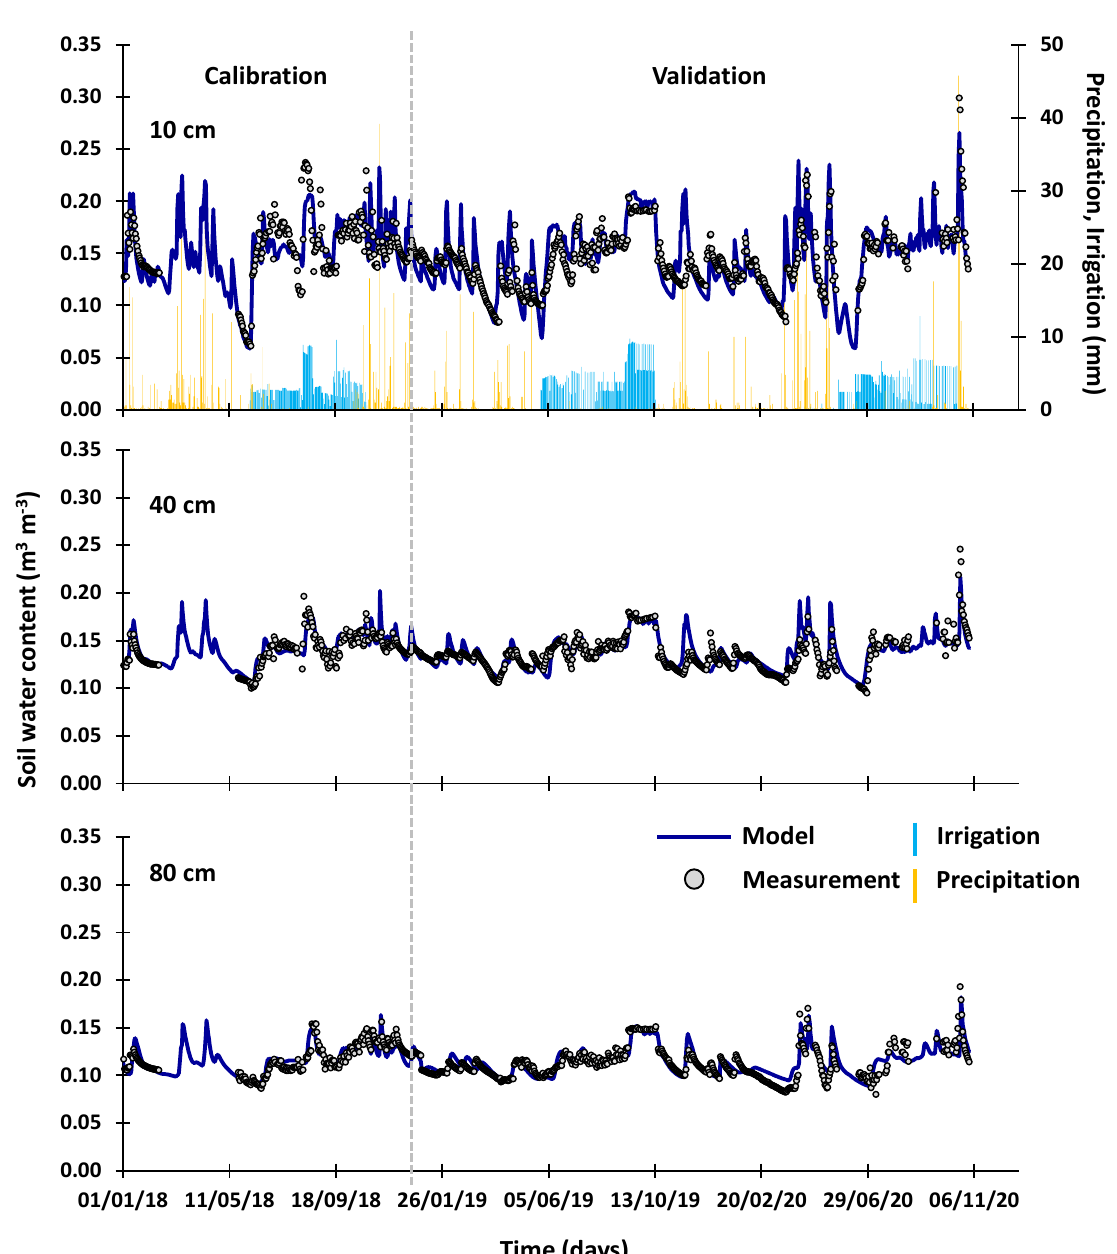
Figure 3. Measured and simulated soil water contents at 10, 40, and 80 cm depths during the 2018, 2019, and 2020 seasons.